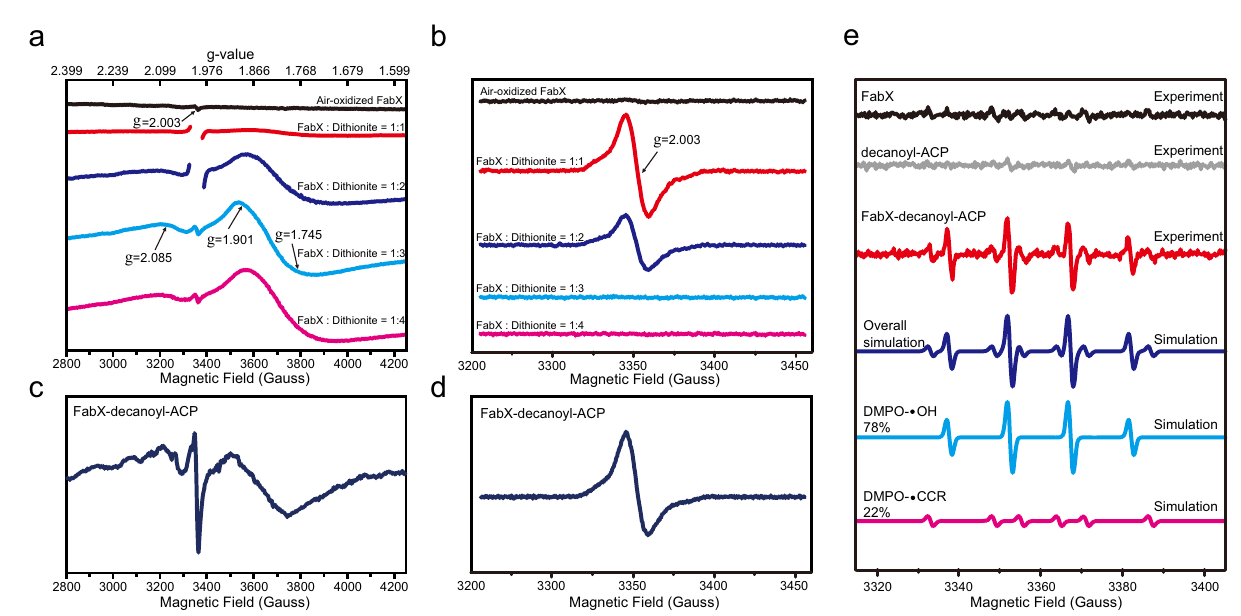
Fig. 5 EPR spectroscopy. EPR spectra were collected at ( a ) 10 K and ( b ) 120 K for reductive titration of air-oxidized FabX after addition of different electron equivalents (with respect to FabX protein) of dithionite. FabX puri fi ed under aerobic condition showed minor peaks corresponding to FMNH • radical (black trace in a ). Different electron equivalents (with respect to FabX protein) of dithionite solution (freshly prepared) were titrated to oxidized FabX under anaerobic condition and EPR spectra were collected using same instrumental parameters. Intense radical signals at g = 2.003 have been omitted in ( a ) (red and blue trace) to highlight the signal of [4Fe – 4S] 1 + . Upon addition of increasing electron equivalents of dithionite, intense signals arose from the FMNH • radical ( g -value of 2.003) and the [4Fe – 4S] 1 + ( g -values of 2.085, 1.901, and 1.745). EPR spectra collected at c 10 K or d 120 K for FabX during catalysis of decanoyl-ACP under aerobic condition. The reactions were quenched by fl ash-freezing in liquid nitrogen after 20 s of incubation at ambient temperature (298 K) for subsequent EPR measurements. The EPR signals corresponding to FMNH • radical and [4Fe – 4S] 1 + were observed. e EPR spin-trapping characterization of FabX-catalyzed dehydrogenation of decanoyl-ACP under aerobic condition. Upper spectra: EPR spectra of DMPO-radical adducts produced from FabX alone (black trace), decanoyl-ACP alone (gray trace), the reaction between FabX and decanoyl-ACP (red trace) are scaled and plotted. The cyan and magenta spectra represent simulations of hydroxyl radical adduct (DMPO – • OH, parameters used for simulation: g = 2.0062, a N = a H = 14.84 G) and carbon-centered radical adduct (DMPO – • CCR, parameters used for simulation: g = 2.0062, a N = 15.82 G, a H = 22.43 G), respectively. The blue trace is the sum of the simulations of the two spin adducts with a ratio of DMPO – • OH:DMPO – • CCR = 78%:22%. Experimental spectra were obtained using a microwave of 1 mW, a modulation amplitude of 1 G, modulation frequency of 100 kHz at room temperature (298 K). Source data are provided as a Source Data fi